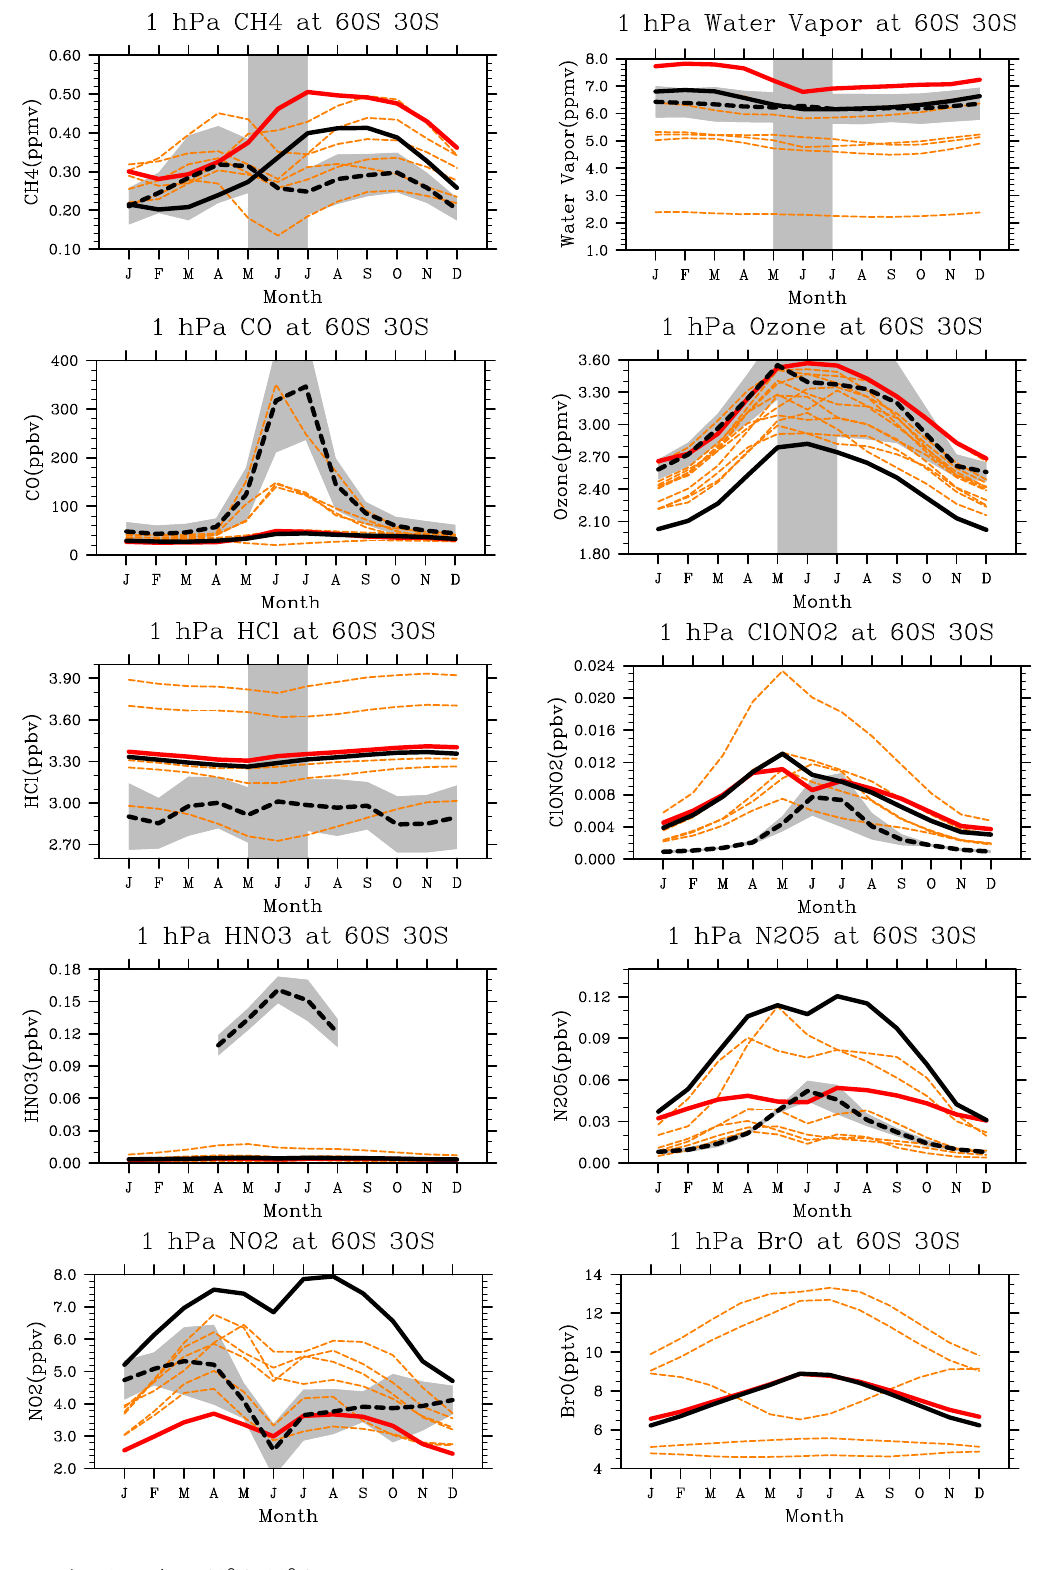
Fig. 16. Same as Fig. 12 at 1 hPa , 60 ◦ S–30 ◦ S.